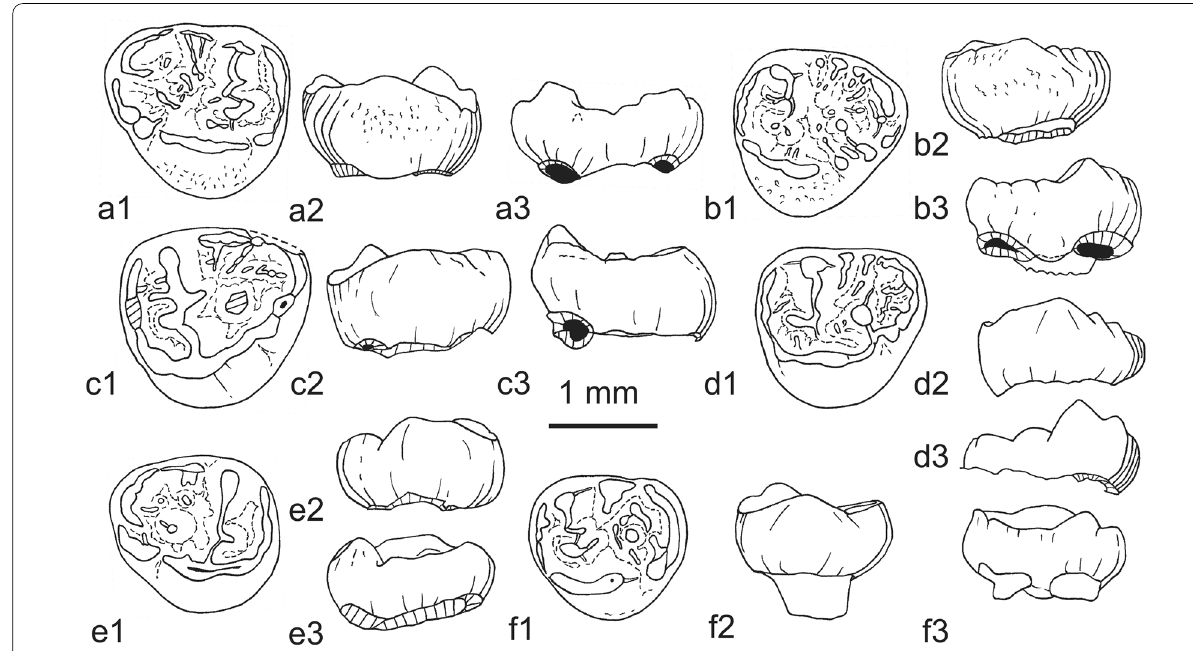
Fig. 32 Upper M3 of ? Protadelomys alsaticus Hartenberger, 1969 from Bouxwiller (Bas‑Rhin). a BUX67‑86, right M3; a1, occlusal view; a2, lingual aspect; a3, buccal aspect. b BUX67‑16, left M3; b1, occlusal view; b2, lingual aspect. c : BUX67‑85, left M3; c1, occlusal view, c2, lingual aspect; c3, mesial aspect. d BUX67‑22, left M3; d1, occlusal view; d2, lingual aspect; d3, buccal aspect. e BUX67‑84, right M3; e1, occlusal view; e2, lingual aspect; e3, buccal aspect. f BUX67‑83, left M2; f1, occlusal view. f2, lingual aspect; f3, buccal aspect. Scale bar: 1